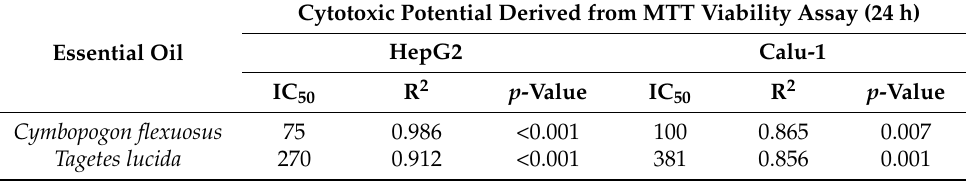
Figure 1. Cytotoxicity in HepG2 ( A ) and Calu-1 ( B ) cell lines exposed to C. flexuosus and T. lucida EOs for 24 h. * Significant difference in viability when compared to control group (C) ( p < 0.05). Data are the mean ± SEM (n = 3). Table 3. Cytotoxic potential of C. flexuosus and T. lucida EOs on HepG2 and Calu-1 cells.